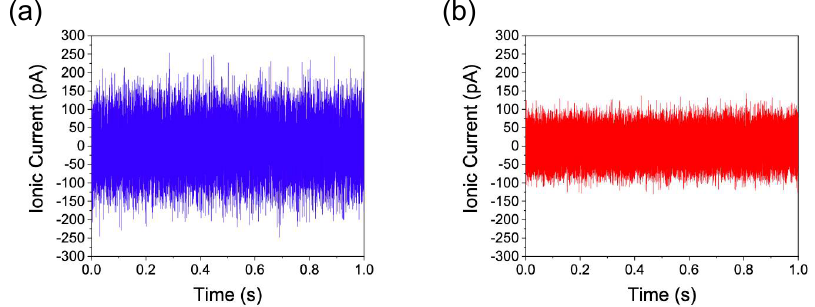
Figure 8. Noise level of the ionic currents. ( a ) Ionic current in a conventional Si 3 N 4 nanopore. ( b ) Ionic current in a Si 3 N 4 /doped Si-based IP-shaped nanopore, i.e., doped Si-based IP-shaped nanopore with a Si 3 N 4 layer. Here, the central value of each current is normalized at 0 A. It was found that peak-to-peak noise level of the IP-shaped nanopore is lower than that of the conventional cylindrical Si 3 N 4 nanopore.